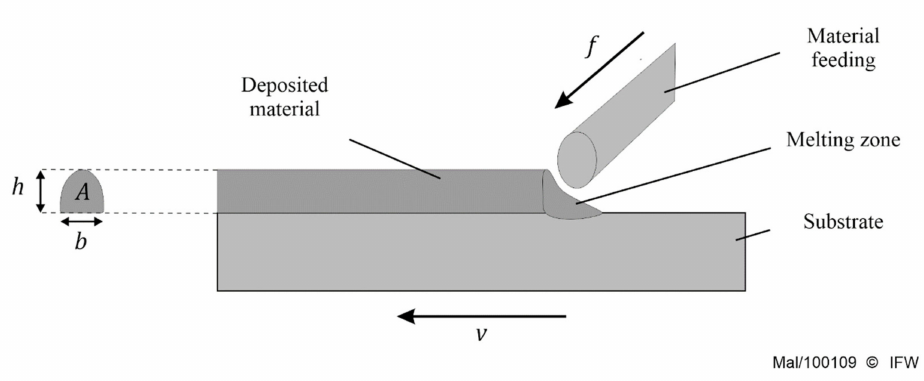
Figure 5. Material deposition in directed energy deposition (DED) processes.